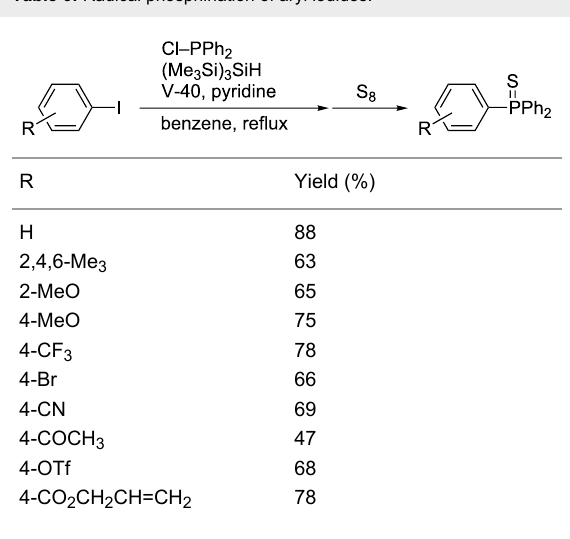
Table 6: Radical phosphination of aryl